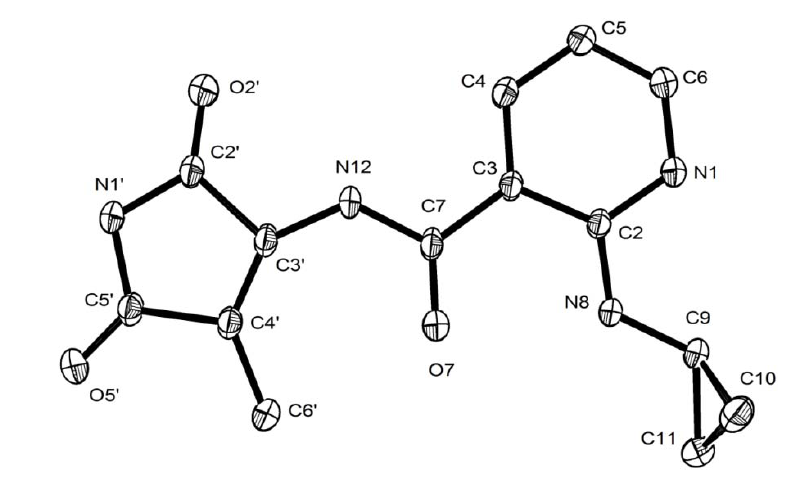
Figure 3. ORTEP diagram, drawn with 50% probability ellipsoids, showing the atomic labelling scheme for compound 14